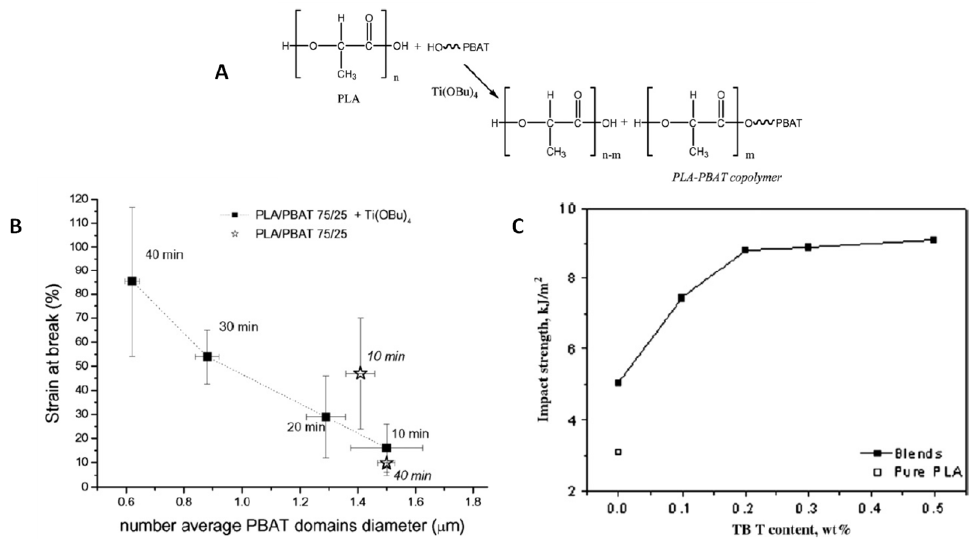
Figure 5. ( A ) Schematic representation of transesterification of PBAT with PLA; ( B ) strain at break as a function of PBAT domain decrease; ( C ) variation of impact strength of PLA/PBAT with catalyst concentration versus pure PLA. Reprinted (adapted) with permission from Refs. [97,98] Copyright 2011 and 2012 Elsevier.